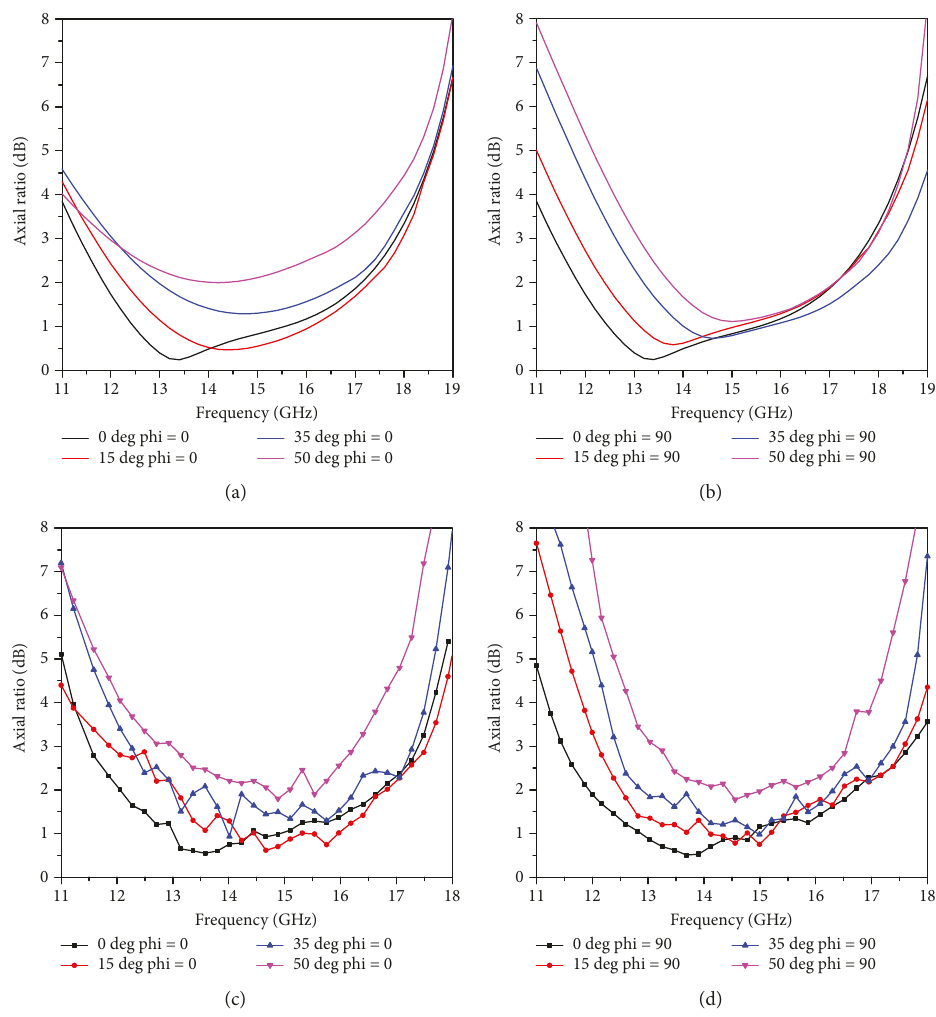
Figure 5: Simulated (a, b) and experimental (c, d) axial ratio results for oblique incidences of 0, 15, 35, and 50 degrees in (a) x-z and (b) y-z planes.